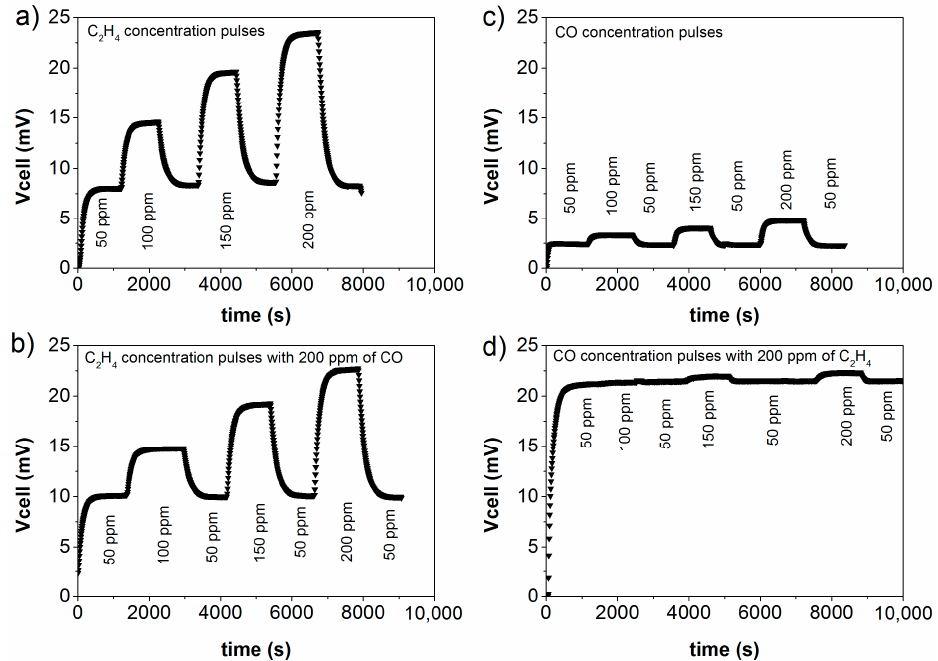
Figure 5. Response curves for changes in concentration of: ( a ) C 2 H 4 , ( b ) C 2 H 4 with 200 ppm CO background, ( c ) CO, and ( d ) CO with 200 ppm C 2 H 4 background. Each change in concentration has 20 min duration and goes from 50 ppm to 100, 150, and 200 ppm. The sensor consists of Fe 0.7 Cr 1.3 O 3 /8YSZ as WE and Pt as RE, at 550 °C with 6% of O 2 .